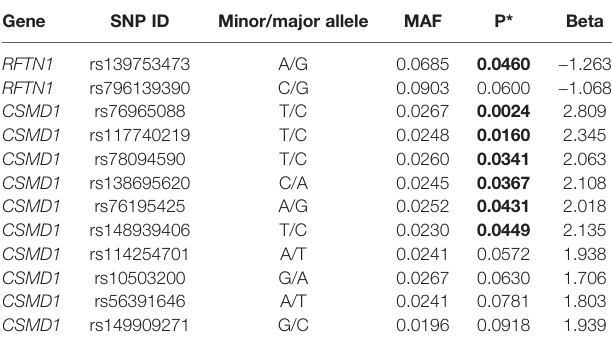
TABLE 3 | Cigarettes per day (CPD)-associated single-nucleotide polymorphisms (SNPs) within RFTN1 and CSMD1 in the replication sample.